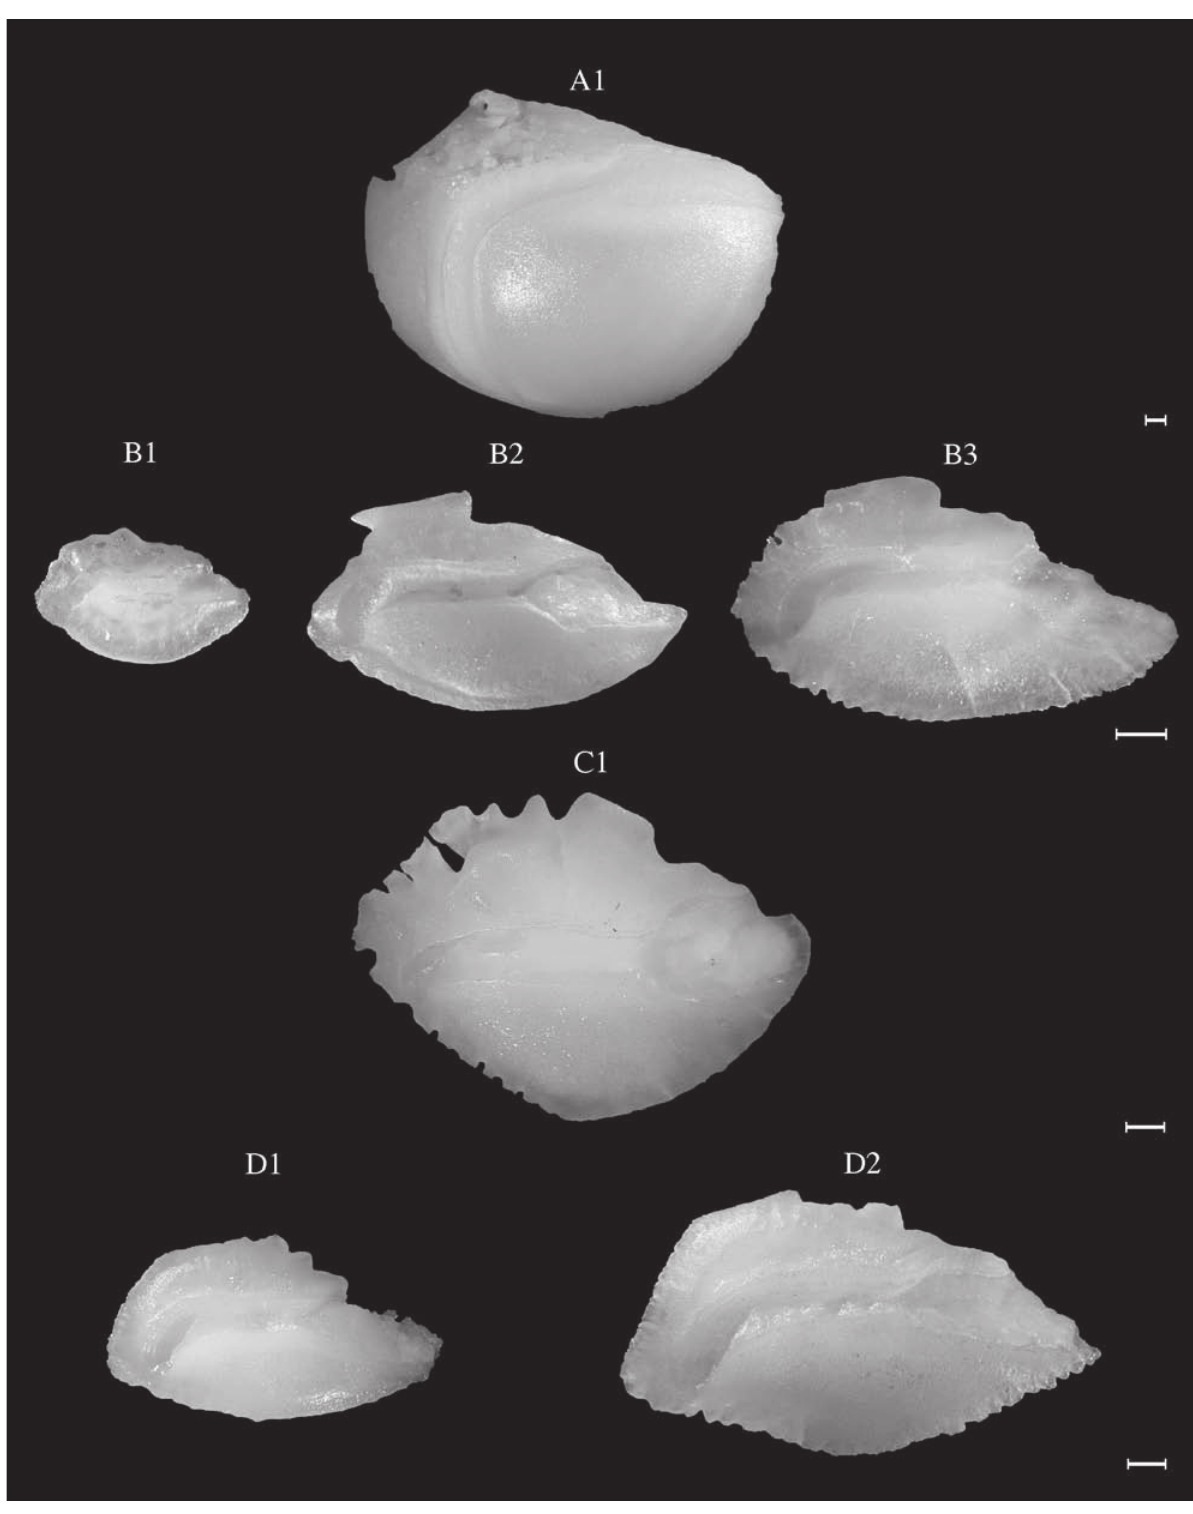
Fig. 56. – Pomadasys perotaei (CEA). TL: A1, 40.4 cm. Boops boops . TL: B1, 13.5 cm (WM); B2, 23.6 cm (NEA); B3, 31.2 cm (CEA). Dentex angolensis (CEA). TL: C1, 28.8 cm. Dentex canariensis (CEA). TL: D1, 30.0 cm; D2, 42.5 cm. Scale bar = 1